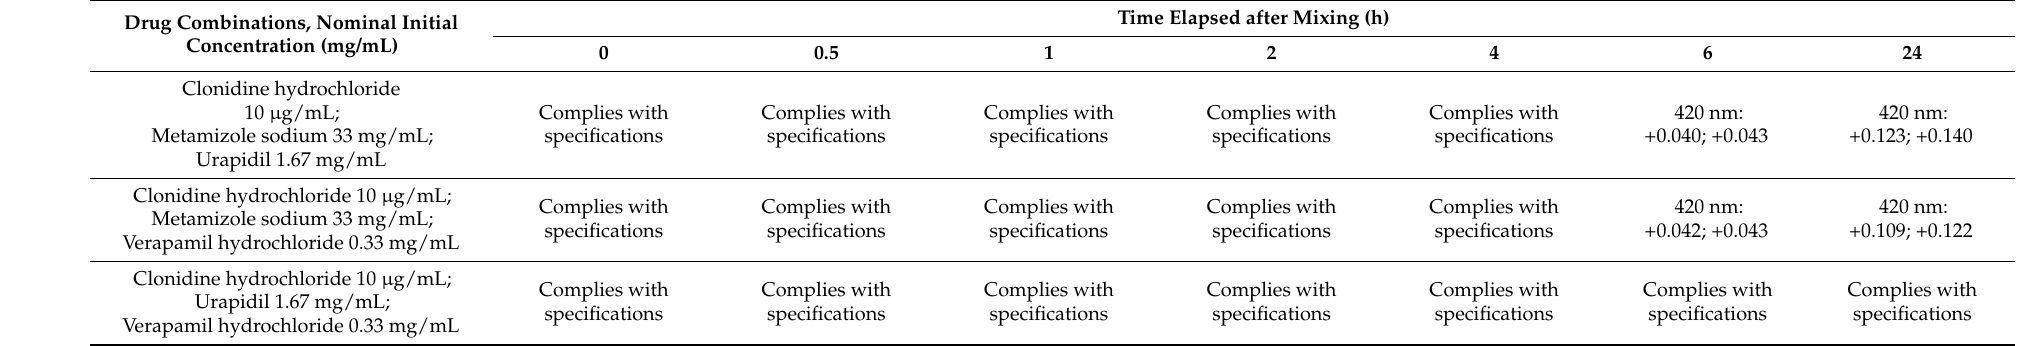
Table A4. Physical compatibility of ternary admixtures.